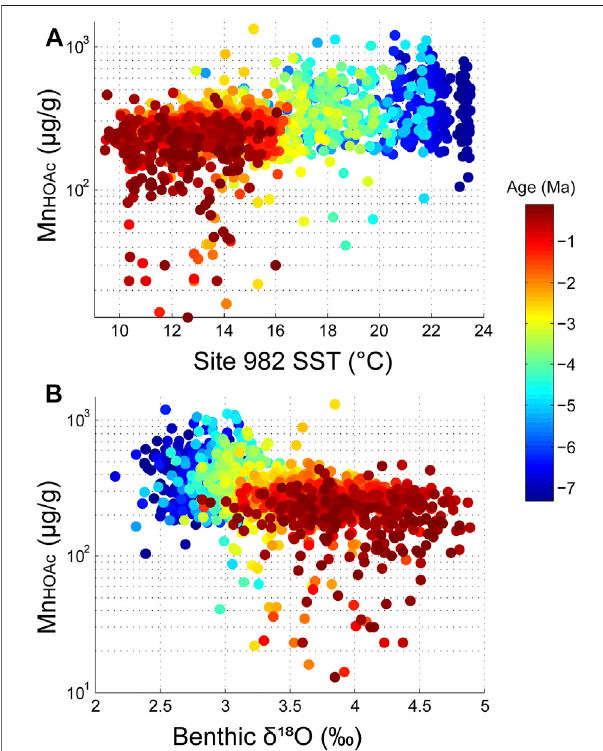
FIGURE 6 | Cross-plots of the Mn HOAc content in the SG-1 and SG-1b cores with the SST in ODP Site 982 (A) and benthic δ 18 O (B) since 7.3 Ma (agesareindicatedbycolourcode).Power fi ts(LnY (cid:1) BX+A)ofMn HOAc versus SST and δ 18 O, yield correlation coef fi cients of 0.707 for (A) and − 0.707 for (B) , respectively ( p < 0.0001). SST and δ 18 O data were interpolated at the same resolution as Mn HOAc .